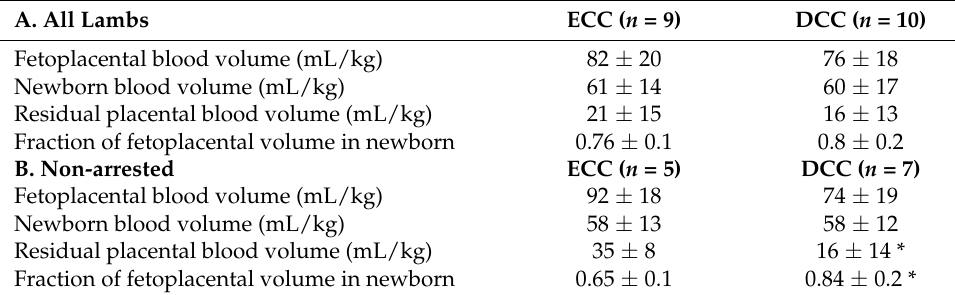
Table 4. Measurement of blood volume and placental